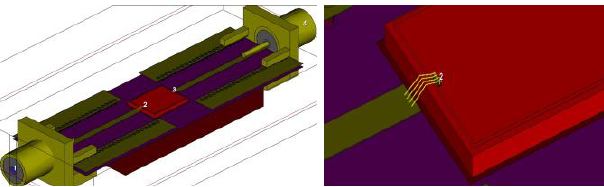
Figure 6: 3D EM simulation setup for the PCB. Left picture full view, right picture zoomed on interconnect.